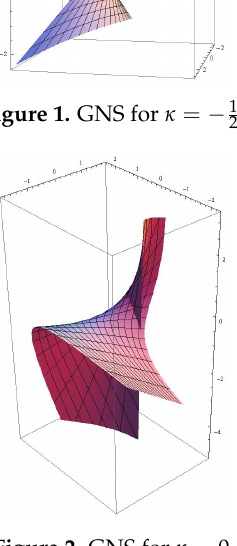
Figure 1. GNS for κ = − 1